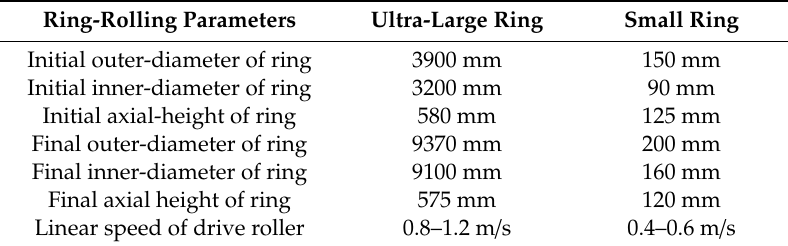
Table 4. Ring-rolling parameters of ultra-large ring and small